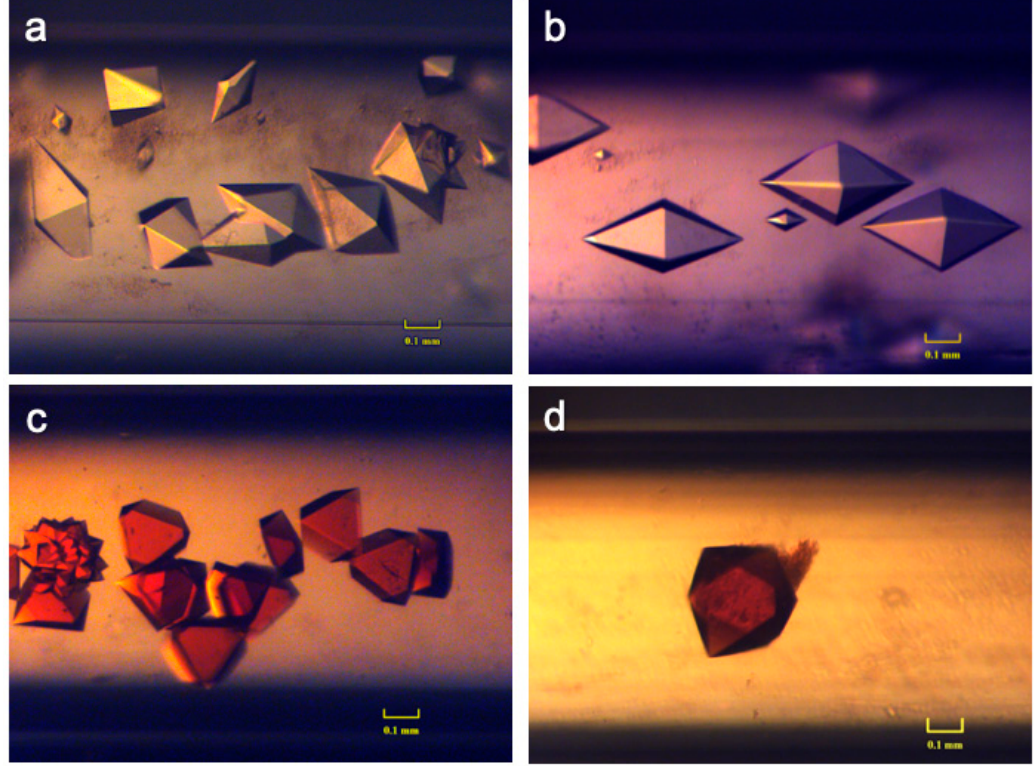
Figure 14. Crystals of thaumatin and ferritin were grown in agarose capillary pipettes; ( a , c ) are the control proteins, showing multiple topological imperfections as well as polycrystalline growth; ( b , d ) are the NMR-bp grown crystals, which have an improved size, homogeneity, and orientation.